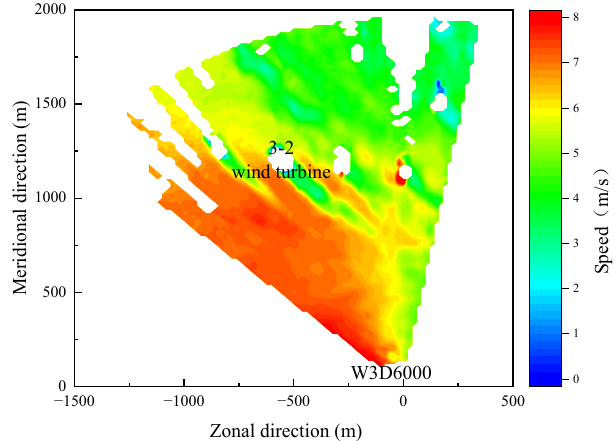
Figure 7. Cloud image of 3-2 wind turbine horizontal profile measured by W3D6000.